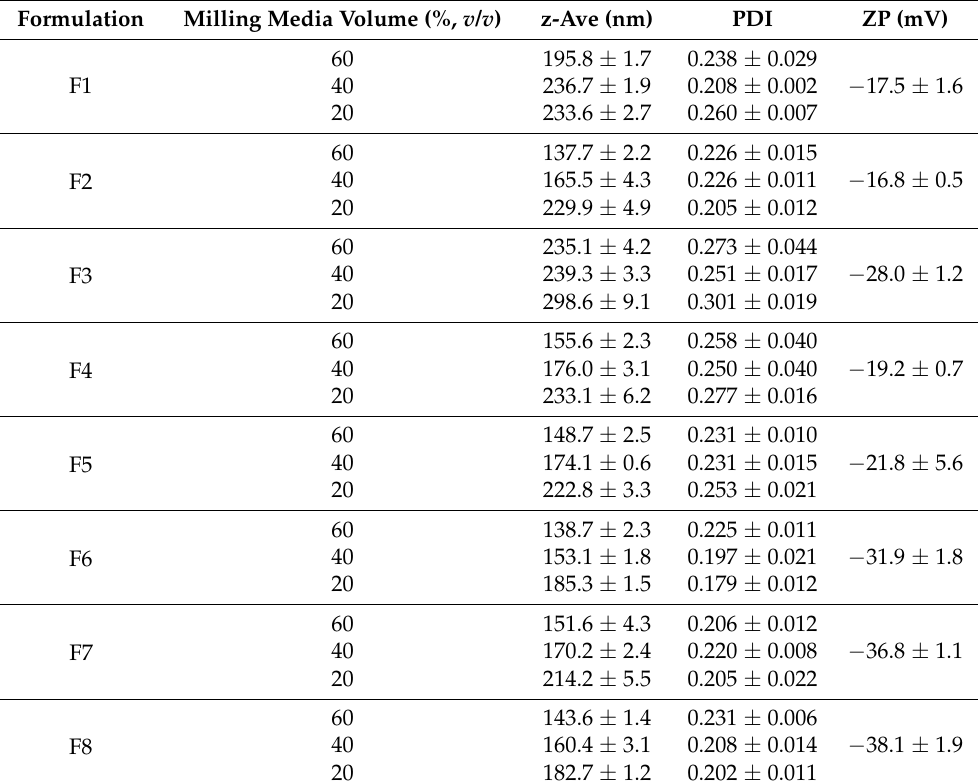
Table 3. Particle size (z-ave), polydispersity index (PDI), and zeta potential (ZP) of nanocrystal dispersions after one hour of milling (mean ± SD, n =